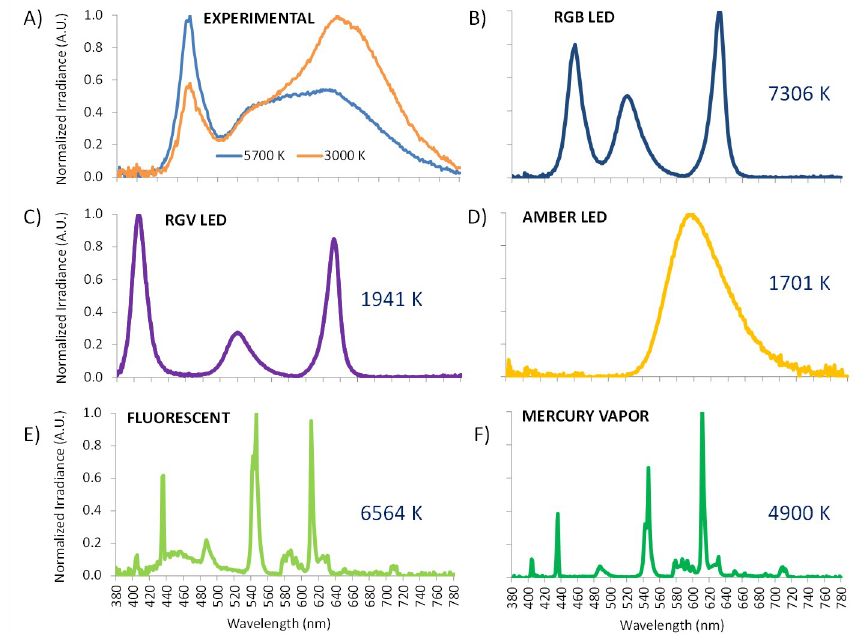
Fig 1. Spectral power distribution of the experimentally tested light sources: 5700 K (blue) and 3000 K (orange) (A) and mathematically assessed [42] light sources: red, green and blue (RGB) monochromatic LED light (7306 K) (B), the same prototype substituting blue for violet (RGV, 1941 K) (C), both of them manufactured at University of Murcia electronic facilities, and three commercial bulbs: amber LED (1701 K) (D), fluorescent light (6564 K) (E) and a mercury vapor bulb (4900 K)